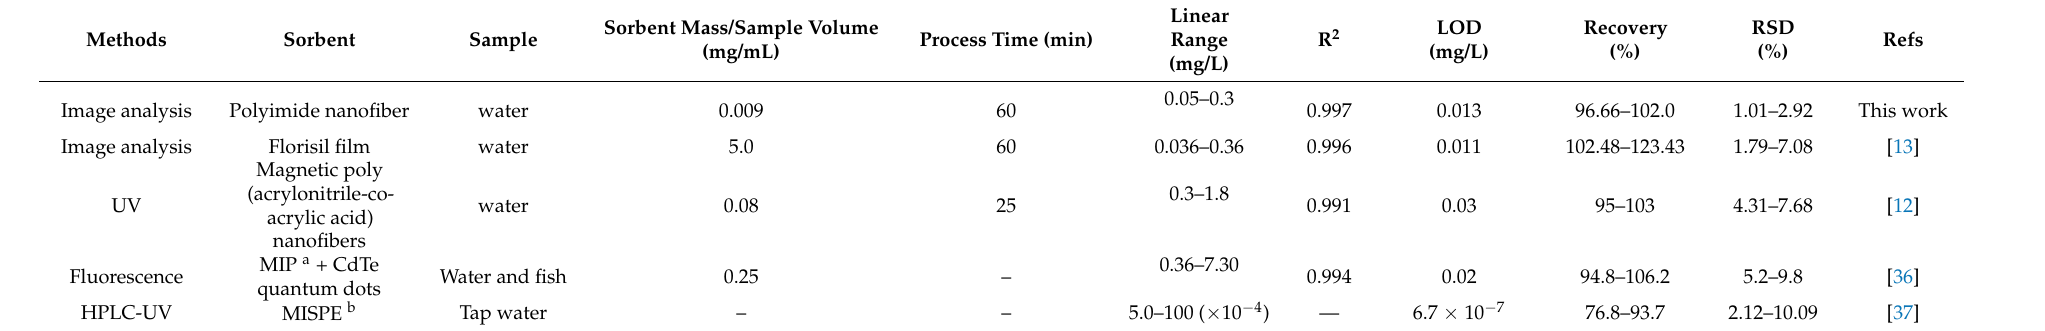
Table 2. Comparison of the proposed method to determine MG in water to other similar